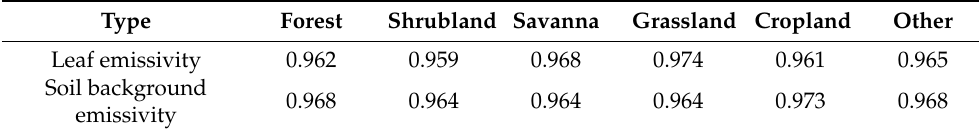
Table 2. The emissivity of leaf and soil of different land cover types. Type Forest Shrubland Savanna